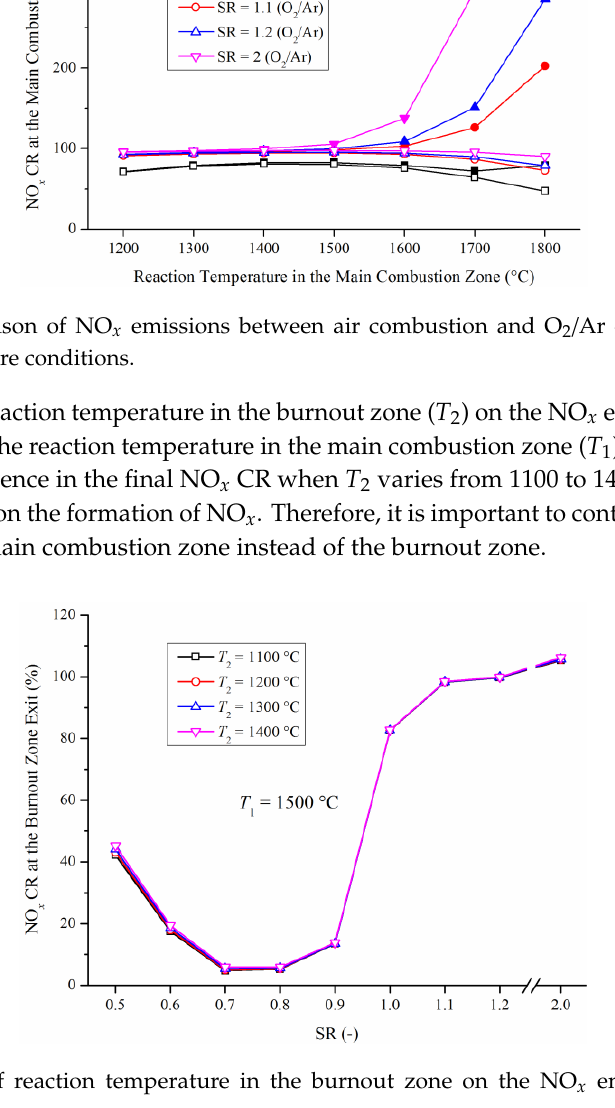
Figure 5. Sums of NH 3 , HCN and NO x at the exits in staged air combustion (reaction temperature in the burnout zone: 1100 °C).